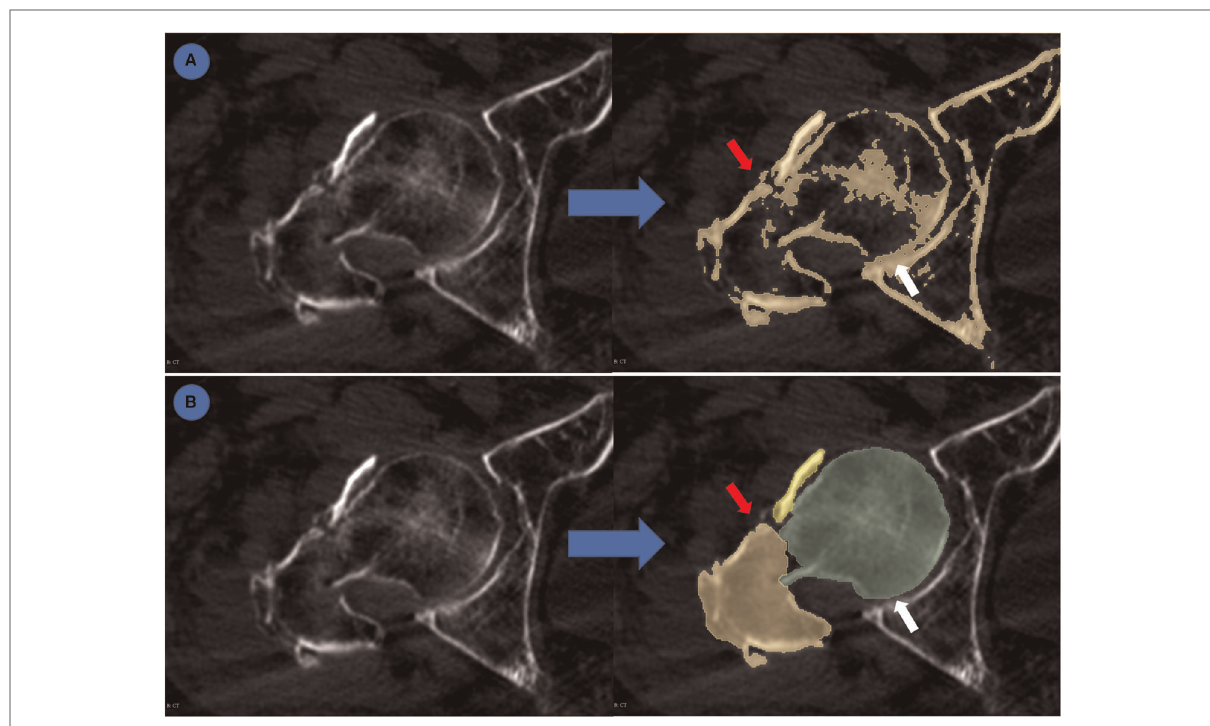
FIGURE 4 Evaluation of semantic segmentation and threshold-based segmentation. ( A ) threshold-based segmentation; ( B ) semantic segmentation. Blue arrow: from original CT to segmented masks. Red arrow: different fracture fragments were highlighted by different colors which made it easy to distinguish. White arrow: adhesion between pelvis and